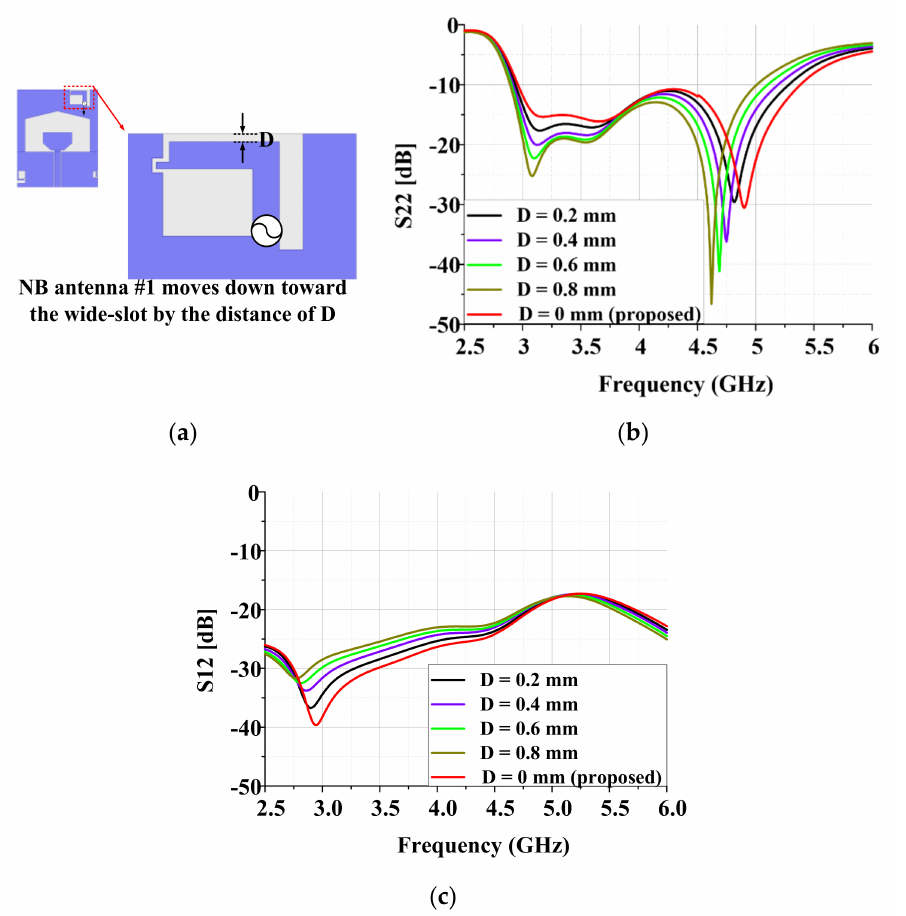
Figure 7. Simulated S parameters for various values of D: ( a ) geometry of NB Antenna #1, ( b ) reflection coe ffi cient of NB Antenna #1, and ( c ) transmission coe ffi cient between the UWB and NB Antenna